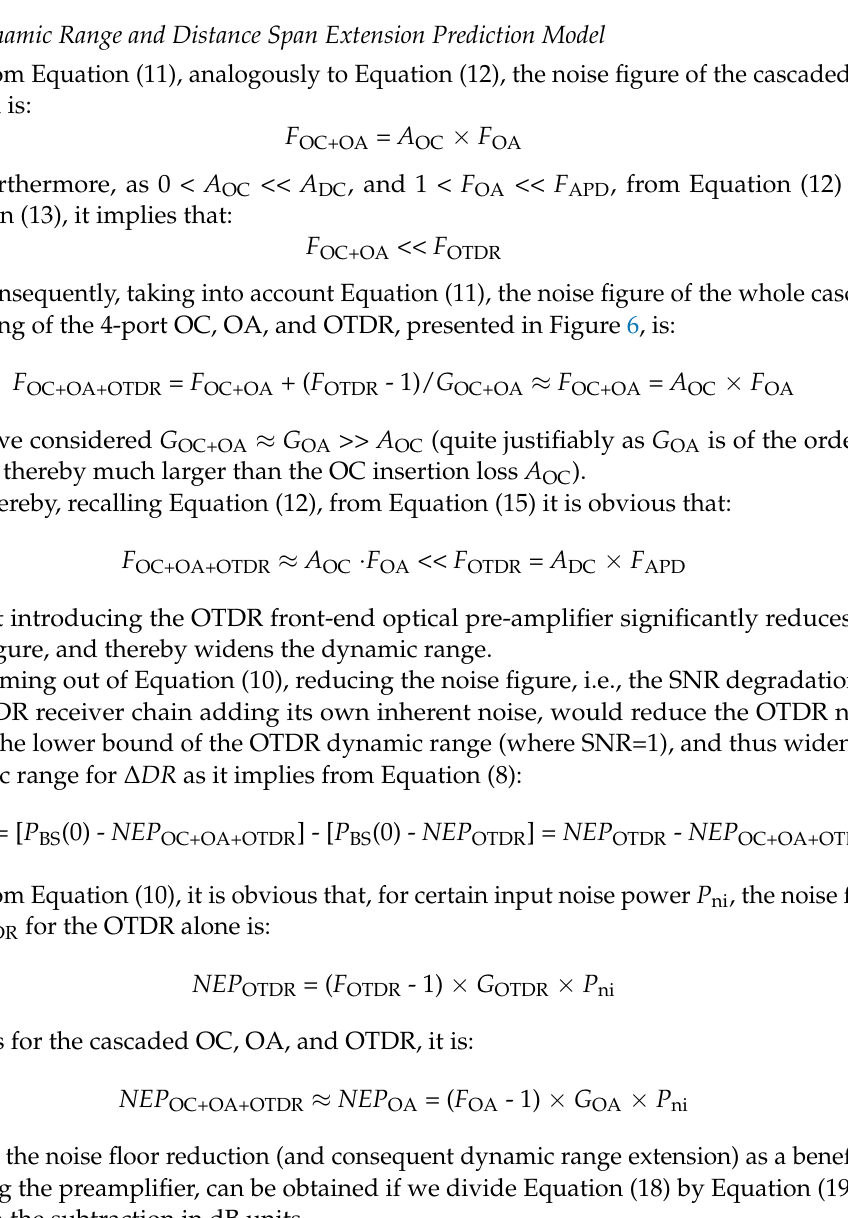
Figure 6. Test configuration: cascaded OC, OA, and